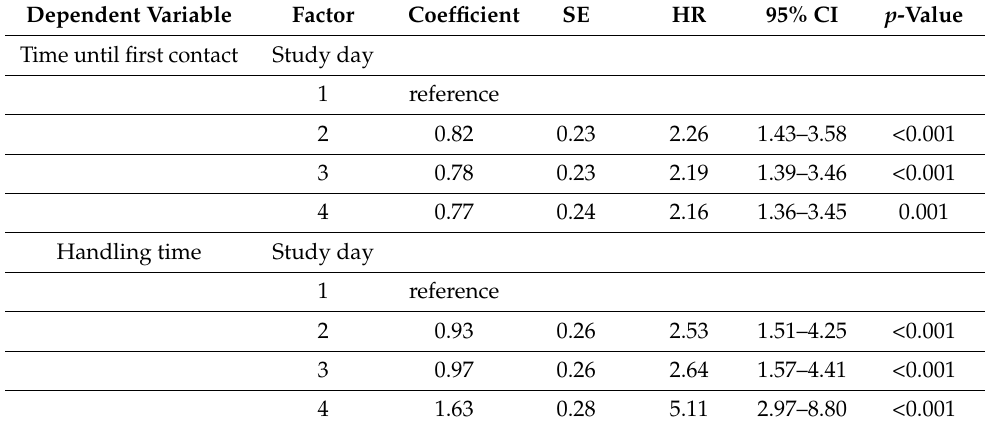
Table 6. The final mixed effects Cox model indicating factors associated with time until first contact with the bait and bait handling time in dogs.